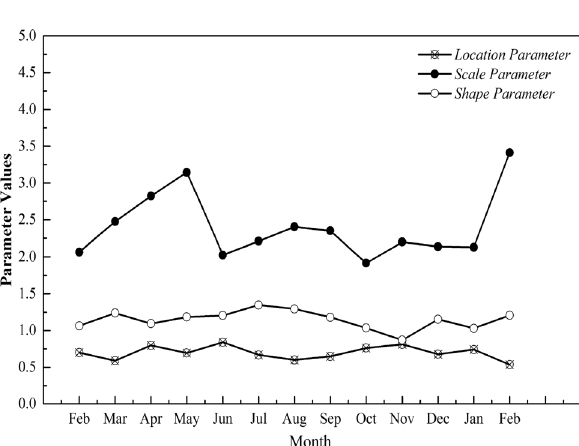
Figure 15. Parameter values at the observed position of 10–19 m (monthly).